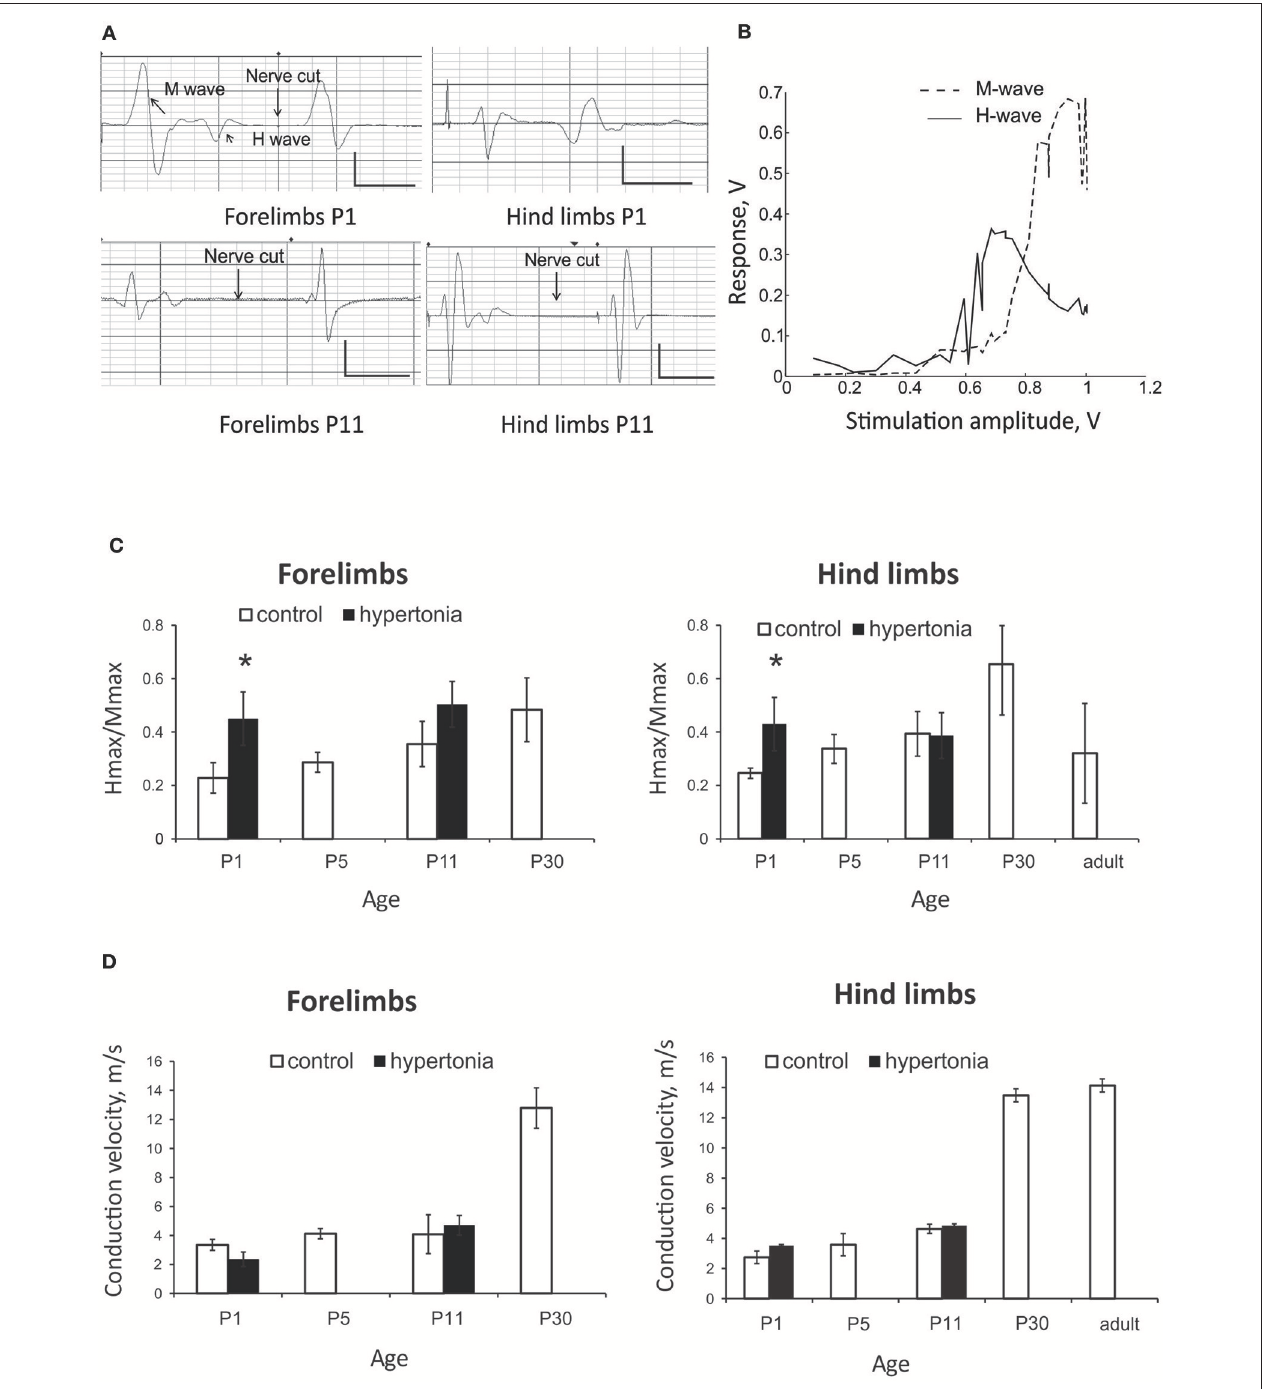
FIGURE 3 | Assessment of monosynaptic H-reflex in development and after antenatal H-I injury. (A) Representative EMG recordings of nerve stimulation in forelimbs and hind limbs at P1 and P11 rabbit kits. Response consisted of M -wave with shorter latency and H-wave with longer latency. H-wave was abolished after nerve cutting (arrows) proximal to stimulation electrode. Calibration bars 0.5 V/10ms. (B) Representative stimulation-response curve of H-reflex recorded on forelimbs of P5 control rabbit. Maximums of H- and M-waves were determined and Hmax/Mmax ratio. (C) Hmax/Mmax increased with age until P30 both in forelimbs and hind limbs in normal development. Hmax/Mmax was significantly increased with hypertonia at P1 but not at P11. (D) Conduction velocity increased with age, but was not altered in hypertonic animals. * p < 0.05.